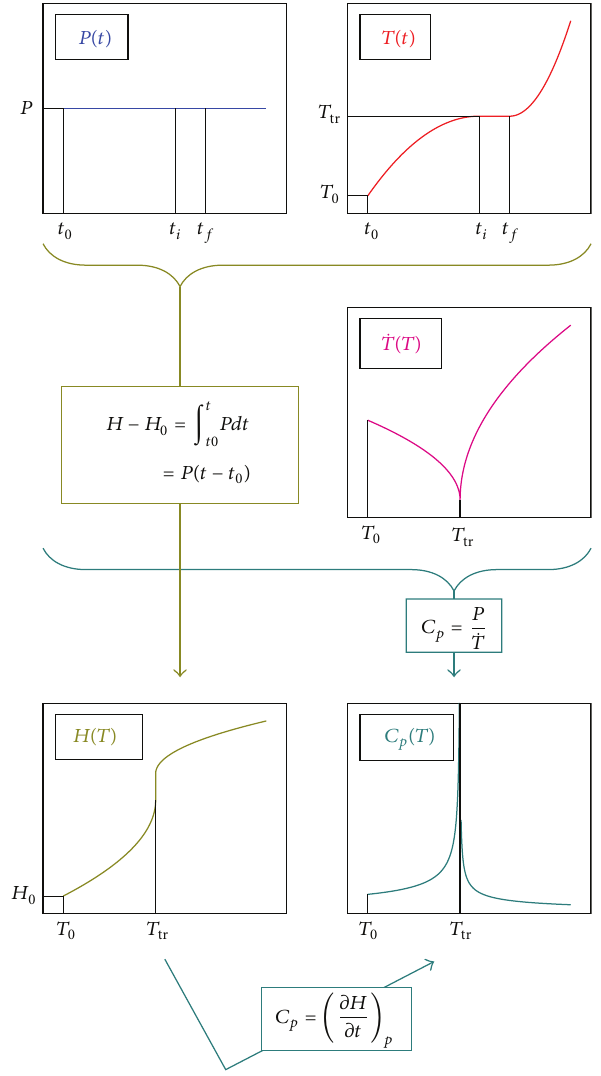
Figure1:SchematicrepresentationofapASCexperimentforatran- sition with a small latent heat and with anomalous pretransitional enthalpy and heat capacity changes. Starting from the constant applied power 𝑃(𝑡) and the measured temperature response of the sample 𝑇(𝑡) , the enthalpy 𝐻(𝑇) and the heat capacity 𝐶 𝑝 (𝑇) can be calculated independently. 𝑇 0 is the starting temperature of the run at the time 𝑡 0 . 𝑡 𝑖 and 𝑡 𝑓 are the beginning and the end of a first-order transition at 𝑇 tr